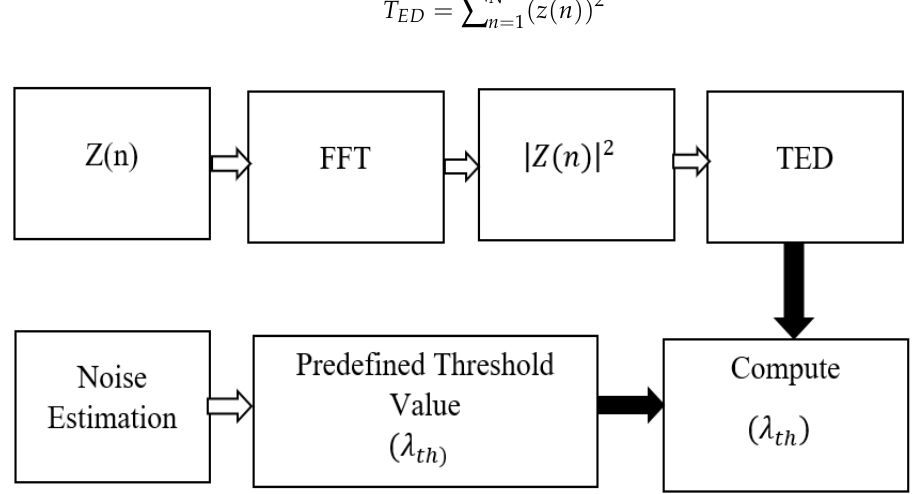
Figure 1. Energy Detection